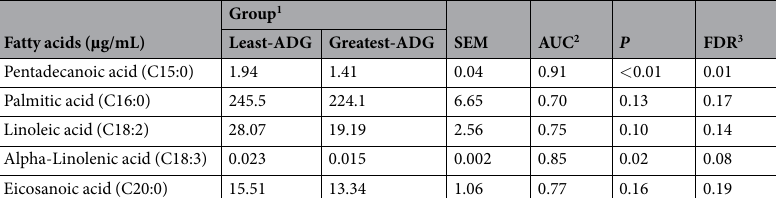
Table 4. Fatty acid concentrations in ruminal fluid on steers with the least and greatest average daily gain. 1 Groups were least-ADG steers (n = 8), with the least average daily gain and greatest-ADG steers ( n = 8), with the greatest average daily gain, with groups having similar dry matter intake. 2 AUC = area under the curve calculated by receiver-operator characteristic curve analysis. 3 FDR = False discovery rate p